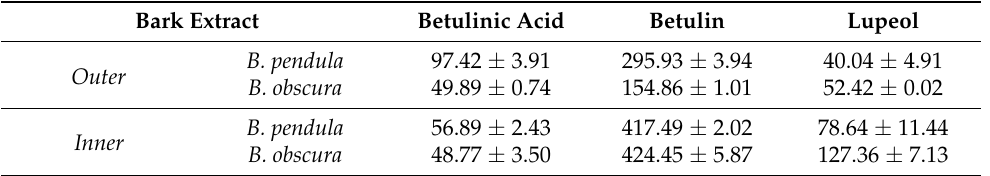
Table 2. Content of triterpenes (mg/g dry extracts ± SD) ( n = 3). Bark